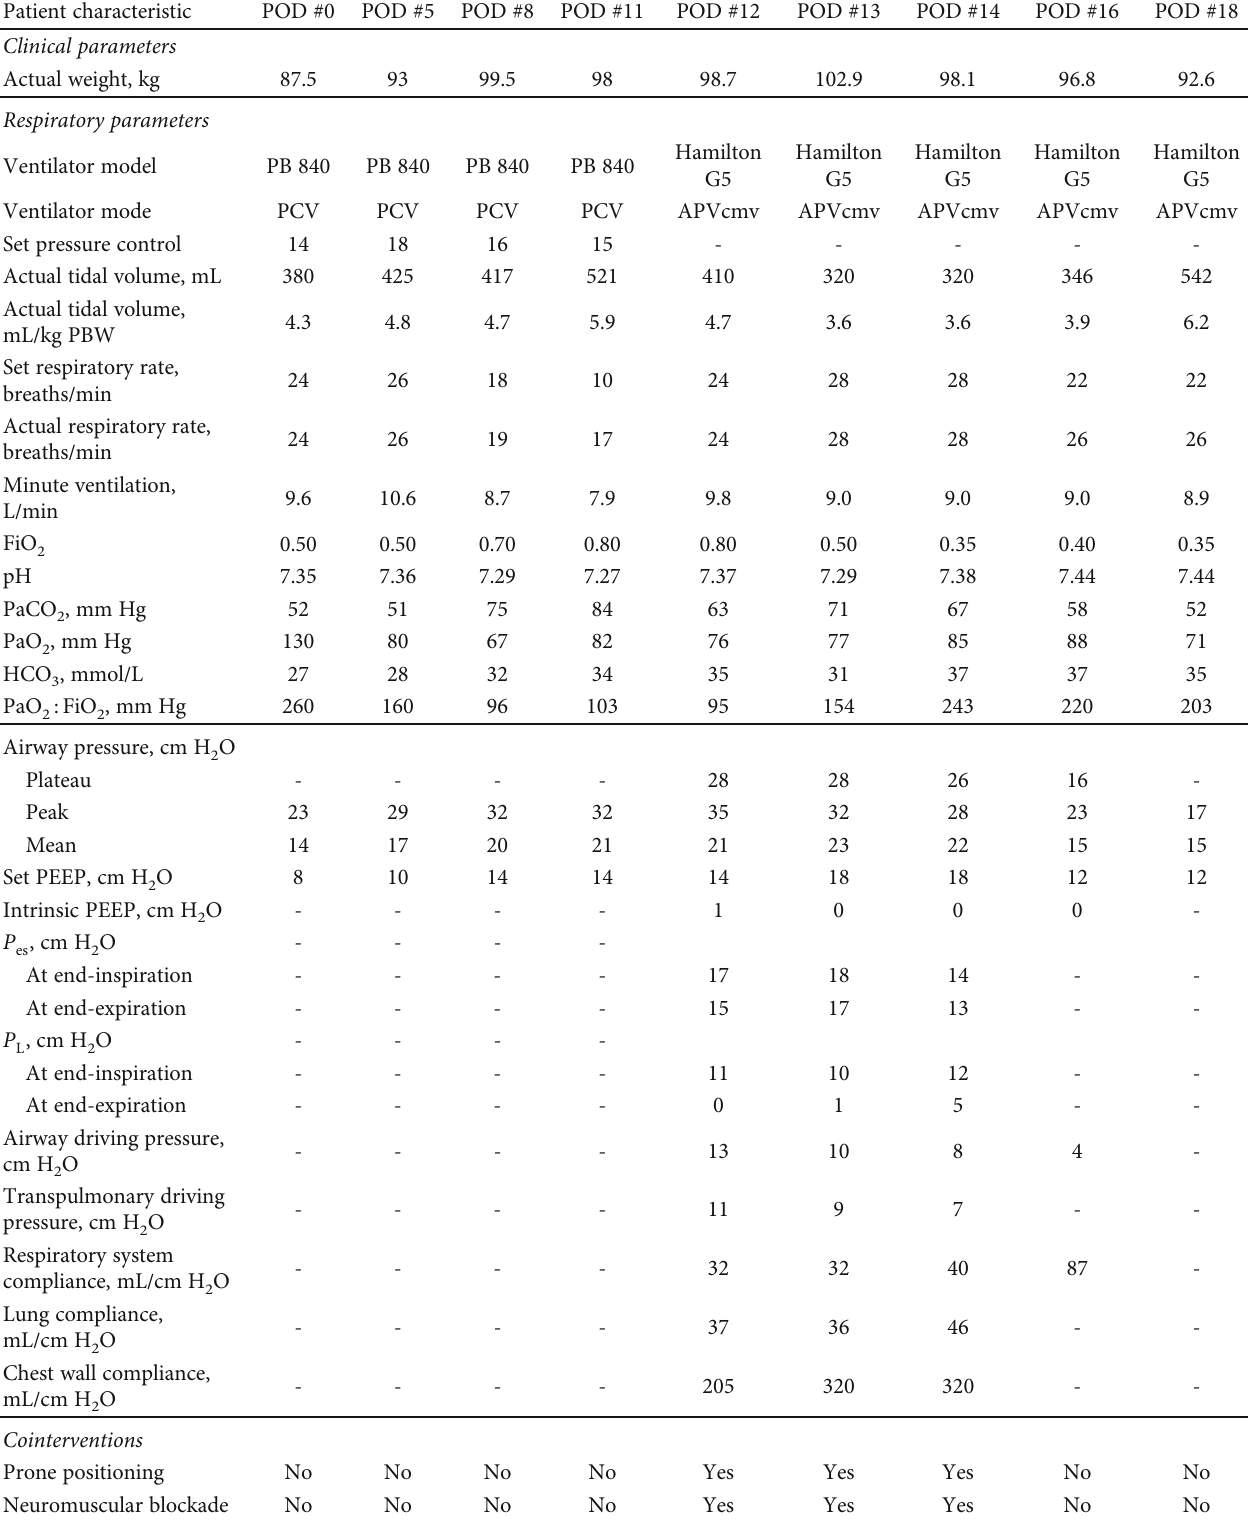
Table 1: Patient clinical characteristics and ventilator parameters during his intensive care unit